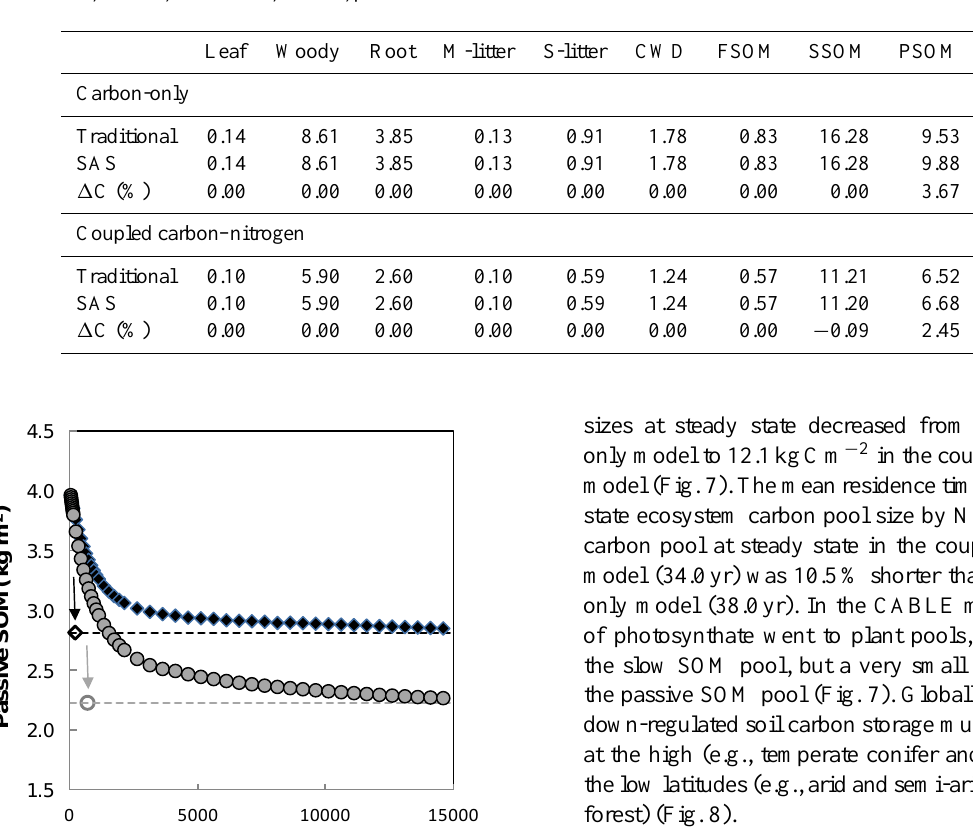
Table 1. Mean steady-state values (kgCm − 2 ) of all pools and their total value (C tot ) from spin-up with traditional and the SAS methods, and the corresponding relative differences ( 1 C; %) for multiple carbon pools. M-litter, metabolic litter pool; S-litter, structural litter pool; FSOM, fast SOM; SSOM, slow SOM; PSOM, passive SOM.